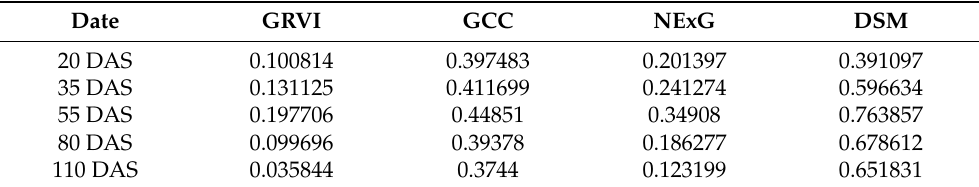
Table 2. The average VI and DSM values for all measurements at the resolution of the reference grid (10 × 10 m 2 ).